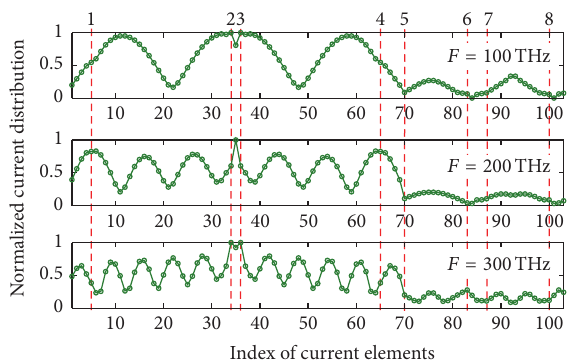
Figure 15: Normalized current distribution along the nanocircuit for F = 100, 200, and 300 THz, with the parameters ℎ 𝑑 = 200 nm, 𝐿 = 1200 nm, 𝑎 𝑑 = 𝑎 𝐿 = 𝑎 𝑒 = 20nm, 𝑑 𝐿 = 60nm, 𝑑 𝑒 = 50 nm, 𝑑 𝑊 = 50 nm, 𝑑 𝐻 = 20 nm, 𝑁 ℎ𝑑 = 5, 𝑁 𝑊𝑒 = 4, 𝑁 𝐻𝑒 = 13, 𝑁 𝐿 = 29, and 𝑁 𝑡 =